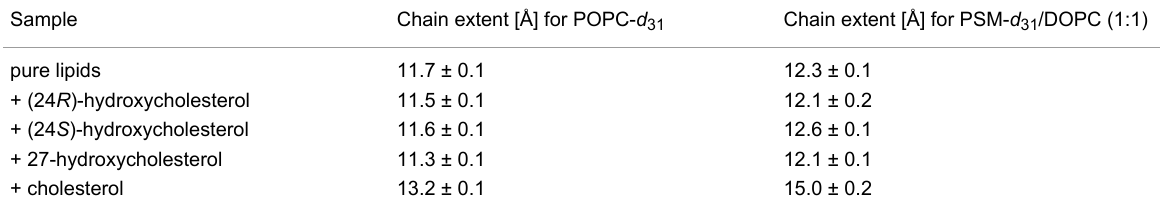
Table 1: The lipid chain extent of membranes consisting of POPC- d 31 without and with the given cholesterols (molar ratio 0.8:0.2) and PSM- d 31 in PSM- d 31 /DOPC/sterol membranes (molar ratio 1:1:1) were calculated using the mean torque model [25,26]. The values for pure POPC- d 31 and in the presence of cholesterol are taken from the literature